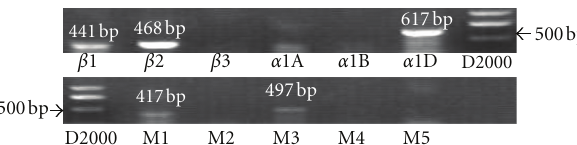
Figure 1: Expression of β 1AR, β 2AR, β 3AR, α 1A, α 1B, and α 1D receptors and M1, M2, M3, M4, and M5 receptors mRNA in Leydig cells of adult mouse testis. β 1AR, β 2AR, α 1D, M1, and M3 receptors. PCR products of 441bp, 468bp, 617bp, 417bp, and 497 bp visual- ized by ethidium bromide staining are shown. D2000, size